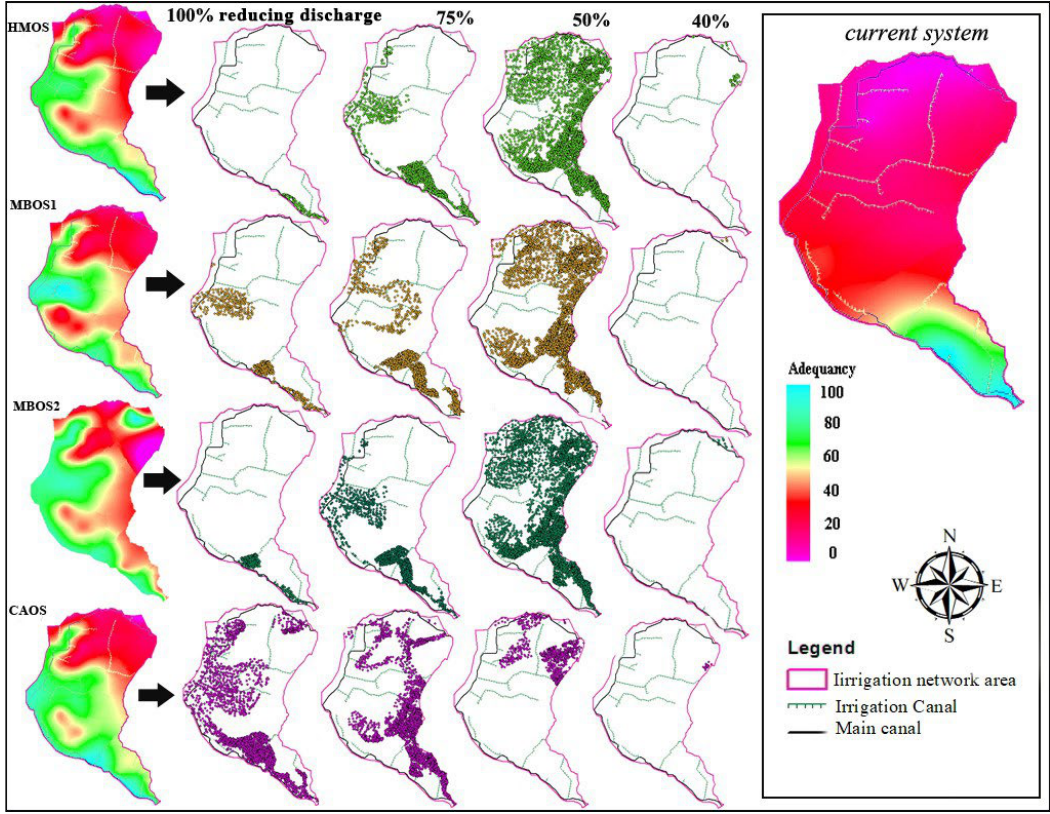
Figure 5. Spatial distribution map of adequacy and area of exploitation wells. Table 3. Number of wells with a reduction in the withdrawal after application of the strategies.